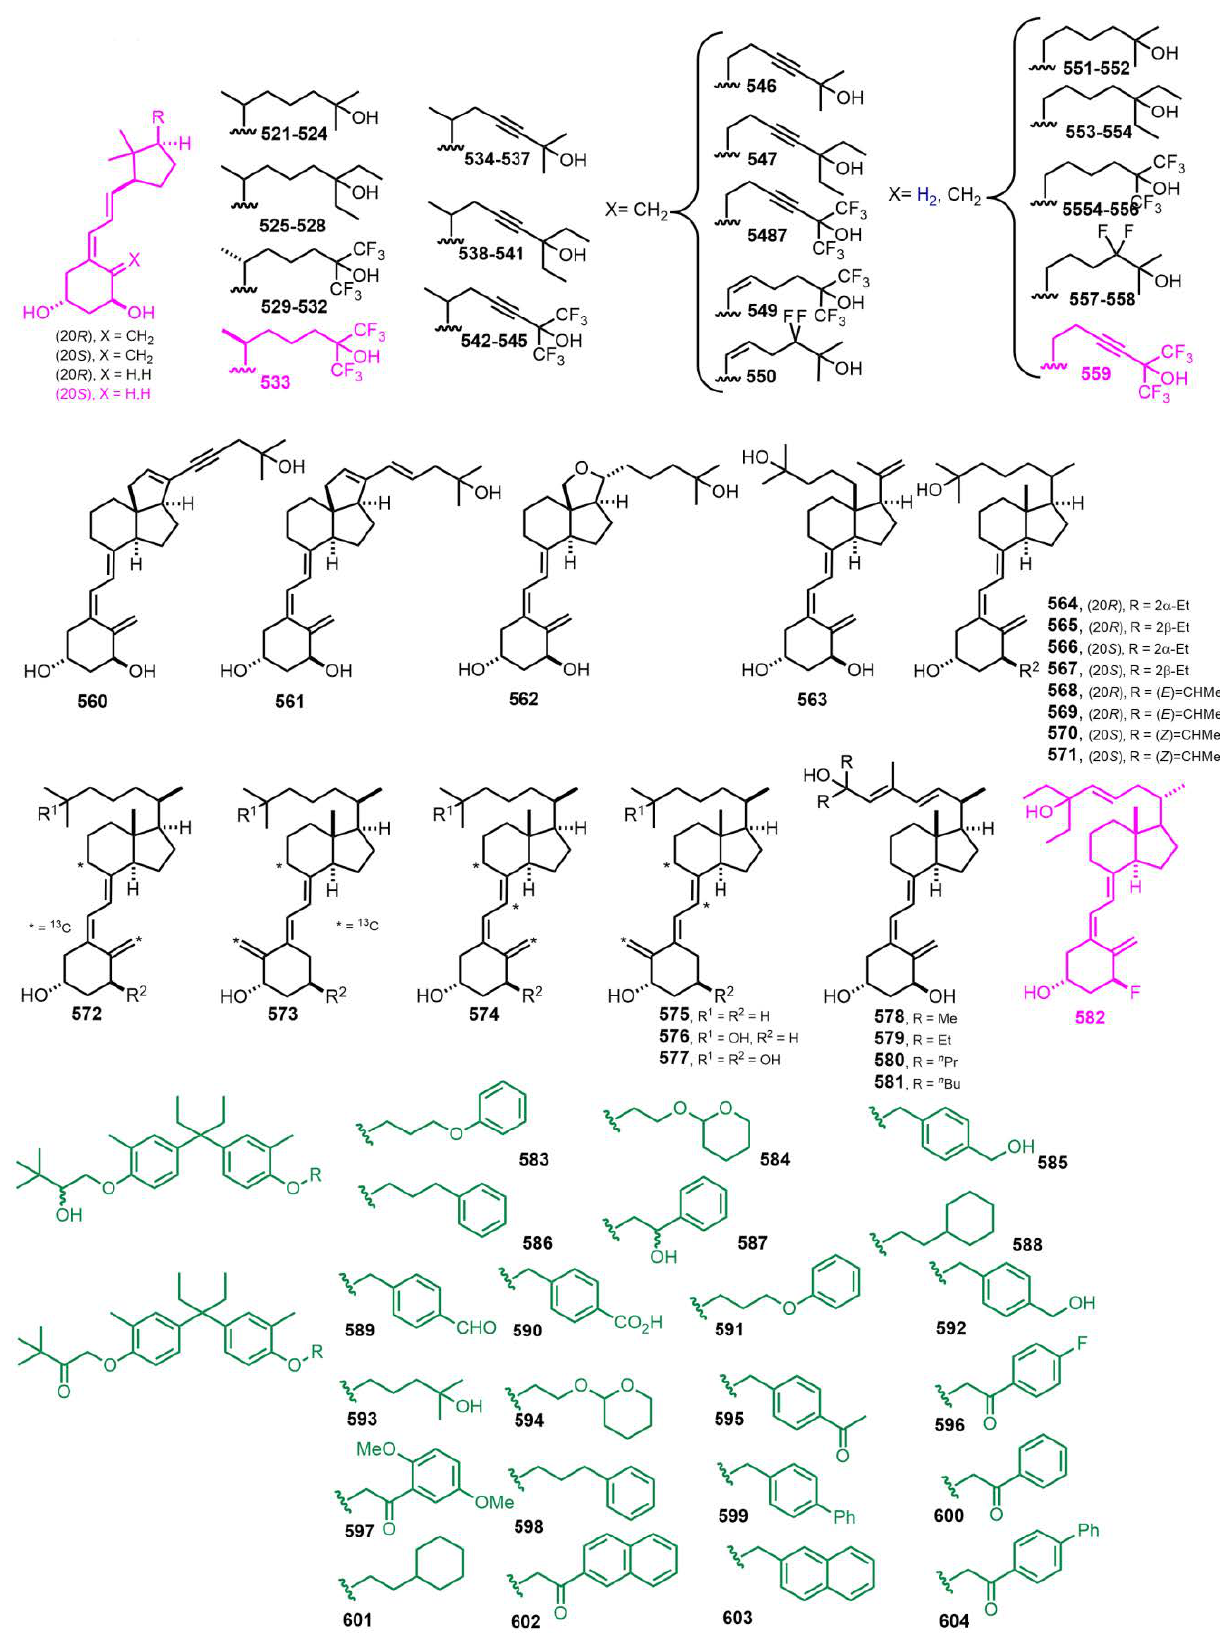
Figure 12. (2002) [197 – 204].